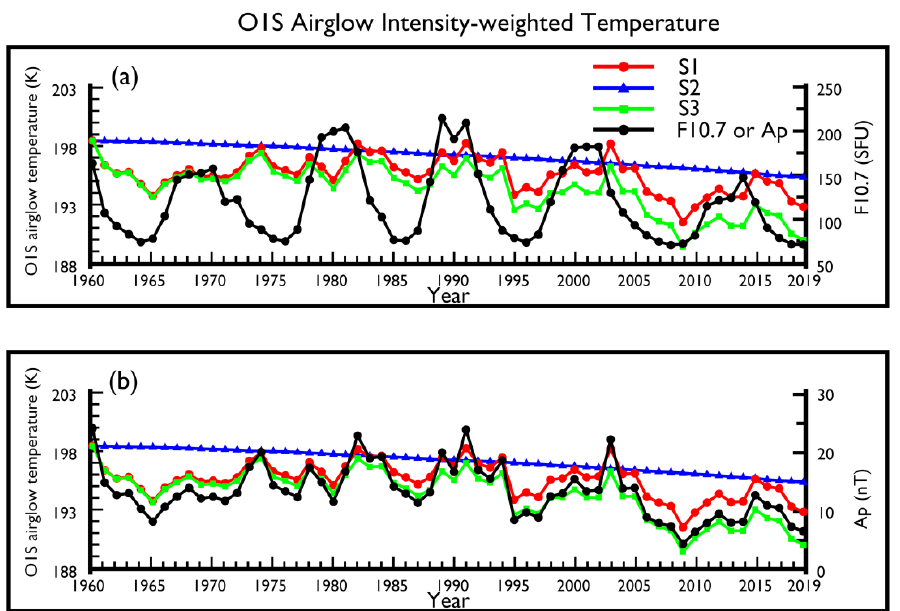
Figure 2. Same as Figure 1, but for the simulated O 2 temperature.